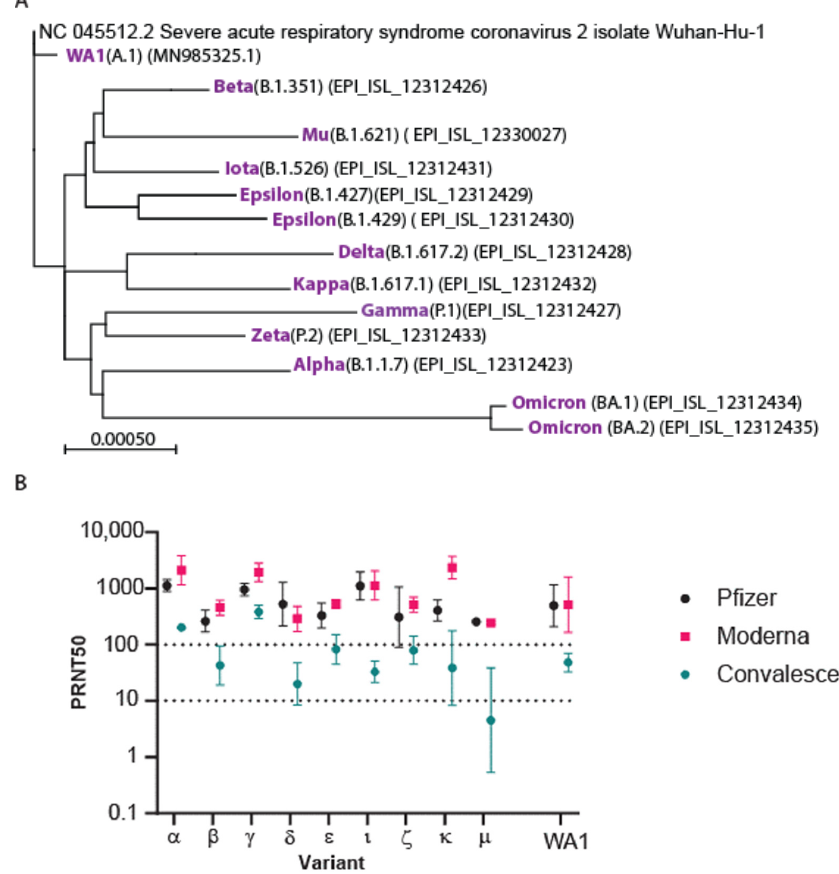
Figure 1. Sequence and neutralization comparison of SARS-CoV-2 variants. ( A ) Phylogenetic tree showing relationships among SARS-CoV-2 variants isolated from patient samples in Seattle, WA, with the SARS-CoV-2/Wuhan-Hu-1 as a reference root. The tree is generated using the online version of MAFFT [42,43] and MEGAX [44]. Tree length is calculated with the maximum parsimony method, the length of the branch is proportional to the number of substitutions. Scale denotes relative genetic distance. ( B ) Geometric mean and standard deviation PRNT50 titer of pooled sera from SARS-CoV-2-naïve individuals vaccinated with Pfizer (BNT162b2) or Moderna (mRNA-12730) vac- cine, and patients recovered from prior SARS-CoV-2 infection (convalescent; Table 1). Sera pools were tested multiple times across independent experiments for their neutralization activity against the indicated SARS-CoV-2 variants. The dotted lines show the 10 and 100 PRNT50 reference levels, with PRNT50 of 10 serving as the lower limit cutoff for virus neutralization activity.